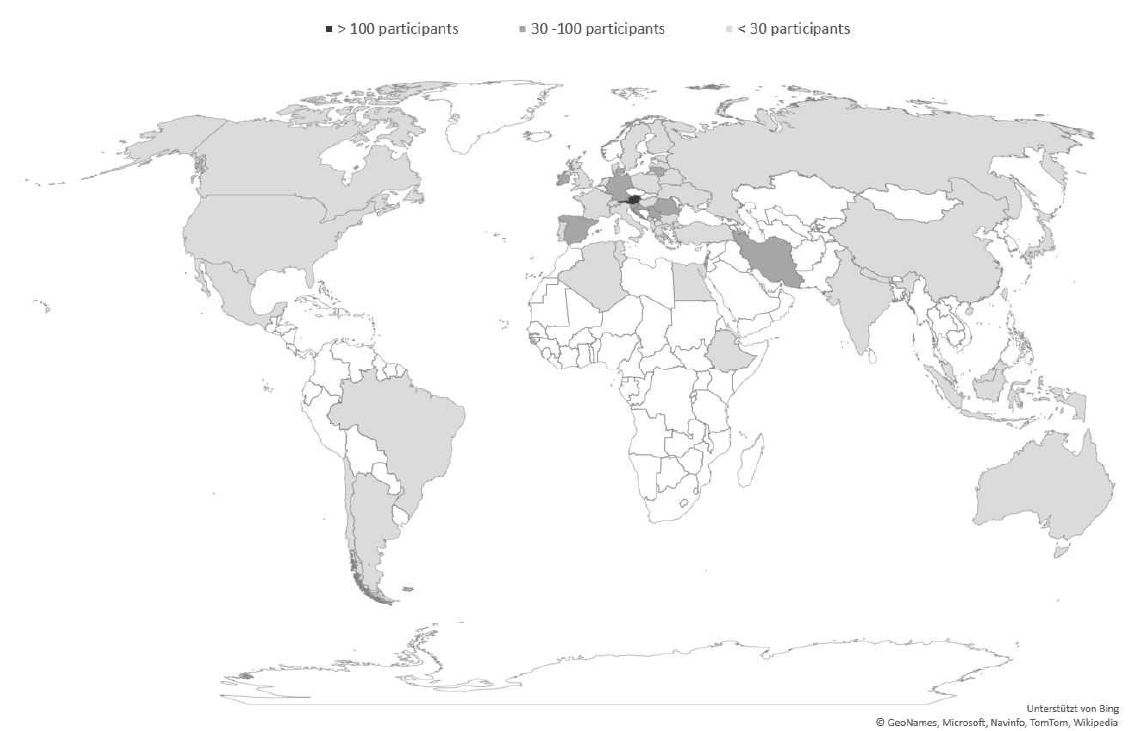
Figure 2. World map showing all participating countries. Light gray color indicates countries with few participants; dark gray color indicates countries with numerous participants. This map was created with Microsoft Excel ® (own figure). Table 2. Main characteristics of participants according to their